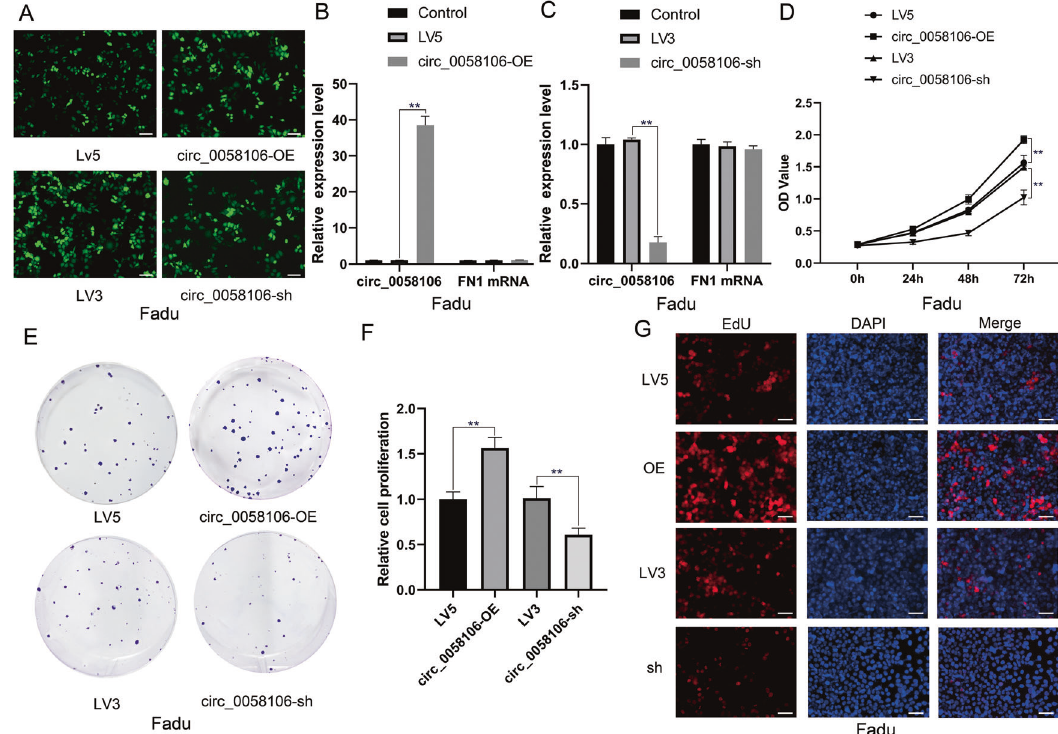
Fig. 2 circ_0058106 overexpression promotes proliferation of HSCC cells in vitro. A GFP-tagged lentivirus in Fadu cells was observed by fl uorescence microscope. (Scale bars = 100 μ m) B Circ_0058106 and parental gene FN1 mRNA expression levels in circ_0058106 stably transfected and LV5 control Fadu cells were detected by qRT-PCR. ( n = 3, * P < 0.05; ** P < 0.01) C Circ_0058106 and parental gene FN1 mRNA expression levels in circ_0058106 stably knockdown and LV3 control Fadu cells were detected by qRT-PCR. ( n = 3, * P < 0.05; ** P < 0.01) D Proliferation of circ_0058106-OE, LV5, circ_0058106-sh and LV3 Fadu cells was measured by CCK8 assay at 0, 24, 48, and 72 h. ( n = 3, * P < 0.05; ** P < 0.01) E Proliferation of circ_0058106-OE, LV5, circ_0058106-sh and LV3 Fadu cells was measured by colon formation assay. F Quantitative analysis of colon formation assay. ( n = 3, * P < 0.05; ** P < 0.01) G Proliferation of circ_0058106-OE, LV5, circ_0058106-sh and LV3 Fadu cells was measured by EdU assay. (Scale bars = 100 μ